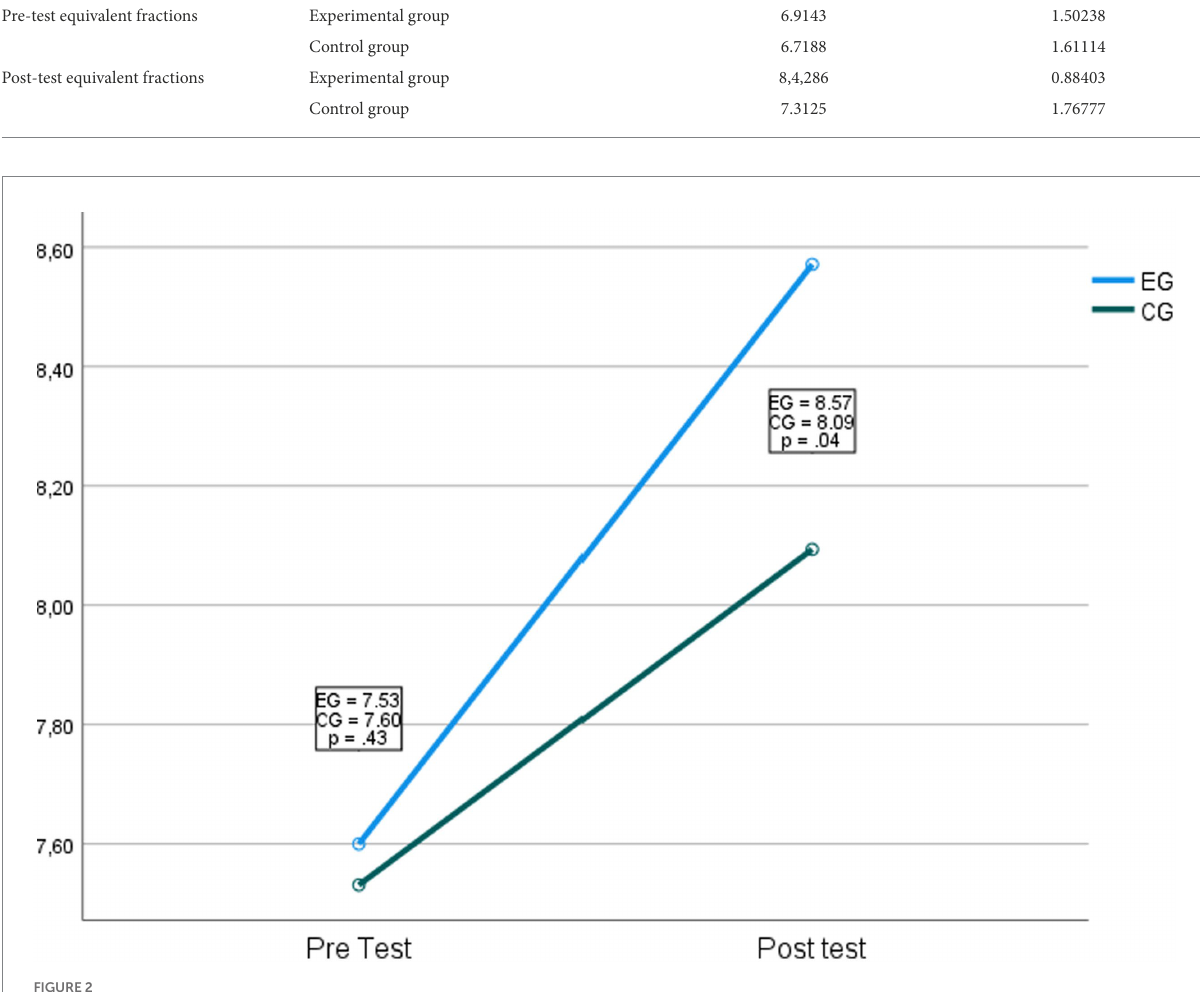
Figure 4 shows significant interaction was found between the approaches and the comparison. the best results in fractions with the students in the experimental group F (1,65) = 4.54, p = 0.03, η 2 = 0.06. Regarding the main effects, statistically significant results were found with the different approaches and performance in fractions